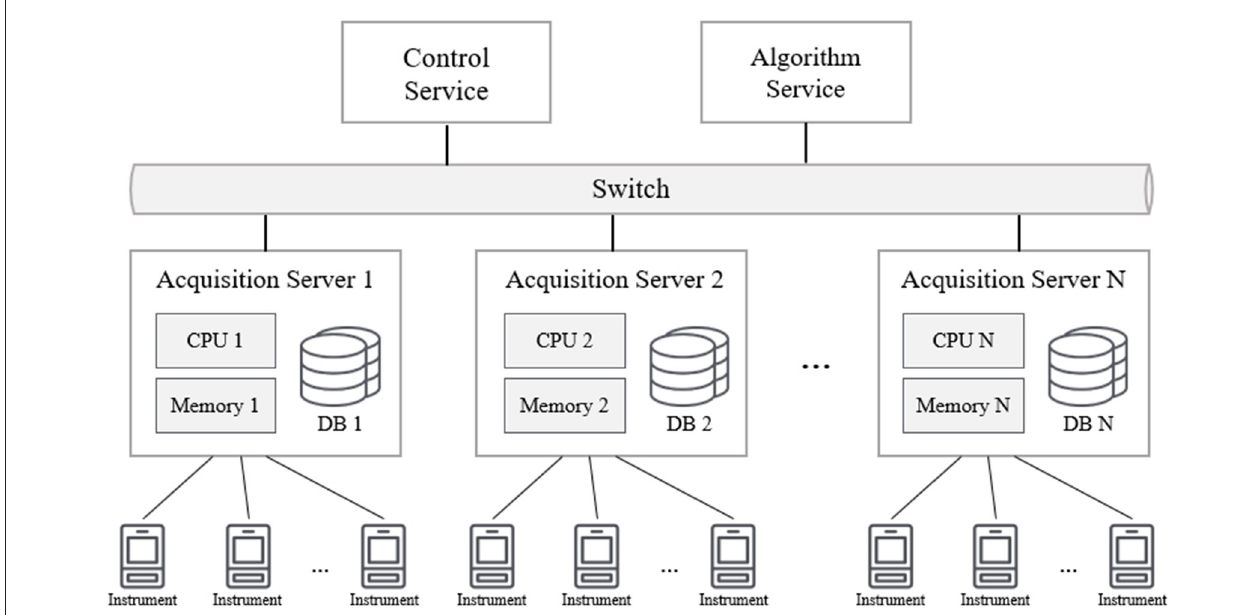
FIGURE 3 | The parallel acquisition architecture.